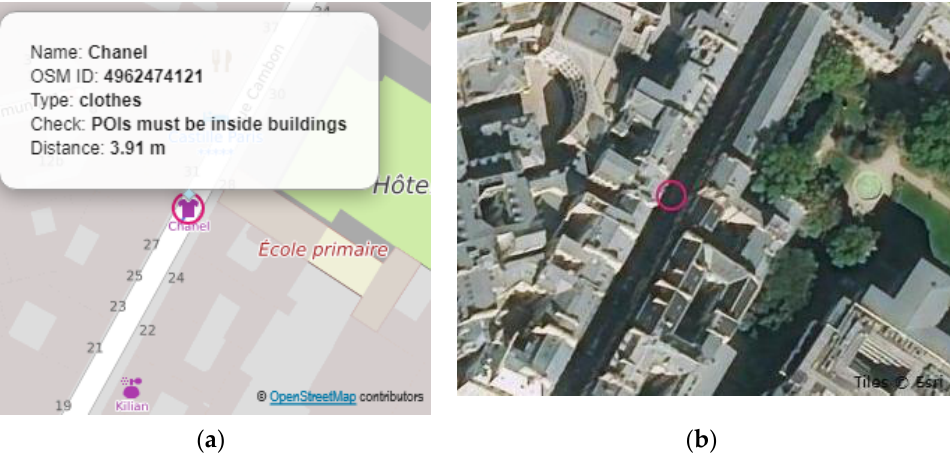
Figure 11. When a POI is clicked on, the user is informed about the “Name”, “OSM ID”, “Type”, “Check”, and distance to the features used in the topo-semantic consistency check ( a ) (Paris). Selection of World Imagery as a basemap may help the user understand the error source (e.g., misplacement or exception) ( b ).